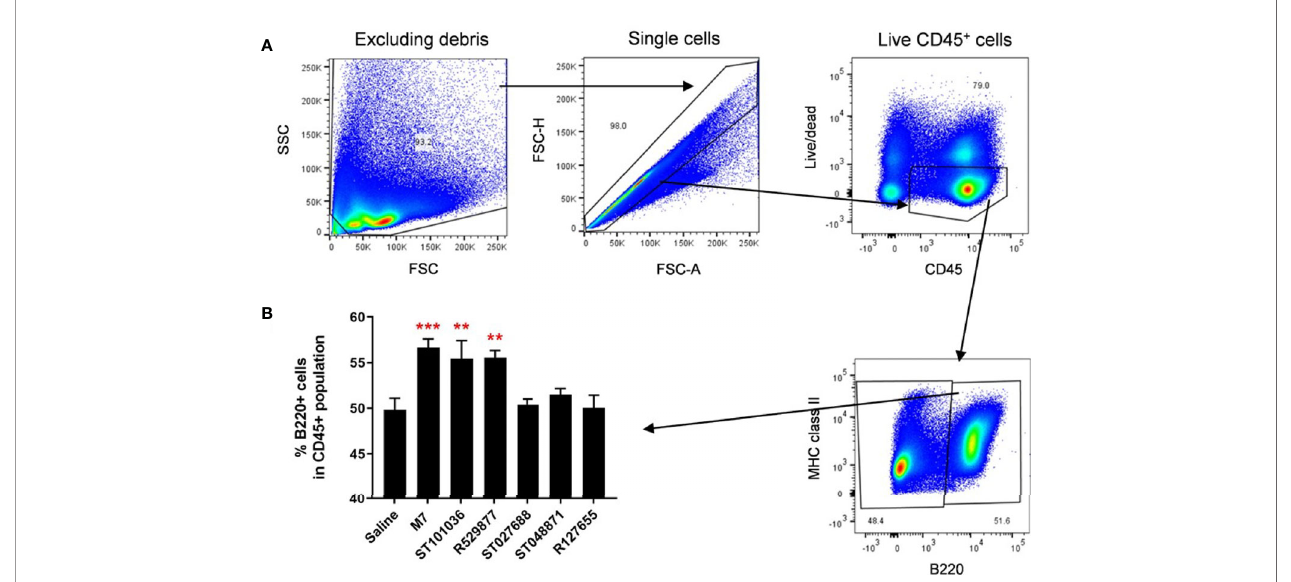
FIGURE 7 | Mast cell activators increase B220+ cells in the cervical lymph nodes after nasal exposure. C57BL/6 mice were nasally instilled with saline, M7, ST101036, R127655, R529877, ST027688, or ST048871. After 24 hours, cervical lymph nodes (cLN) were obtained. Single-cell suspension of isolated cLNs was analyzed by fl ow cytometry (A) . One-way ANOVA determined a signi fi cant increase compared to saline **p < 0.01, ***p < 0.001. Bars represent the mean + SEM (B)